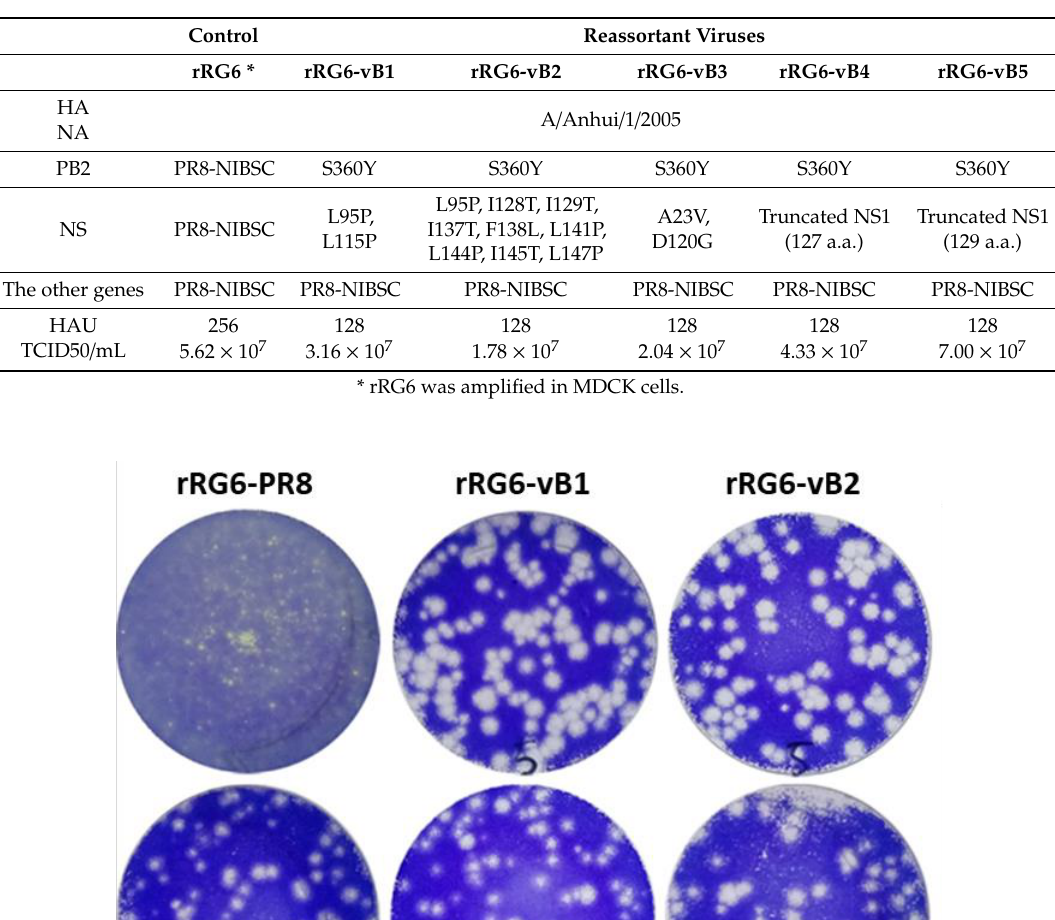
Table 2. Genetic constellation of five reassortant viruses generated using reverse genetics. PR8-NIBSC: A/Puerto Rico/8/34 (H1N1), the current master donor strain using for candidate vaccine viruses from the US Centers for Disease Control and Prevention (CDC) and National Institute for Biological Standards and Control (NIBSC). Amino acid mutations in the NS genes from Vero cell-adapted viruses are shown.